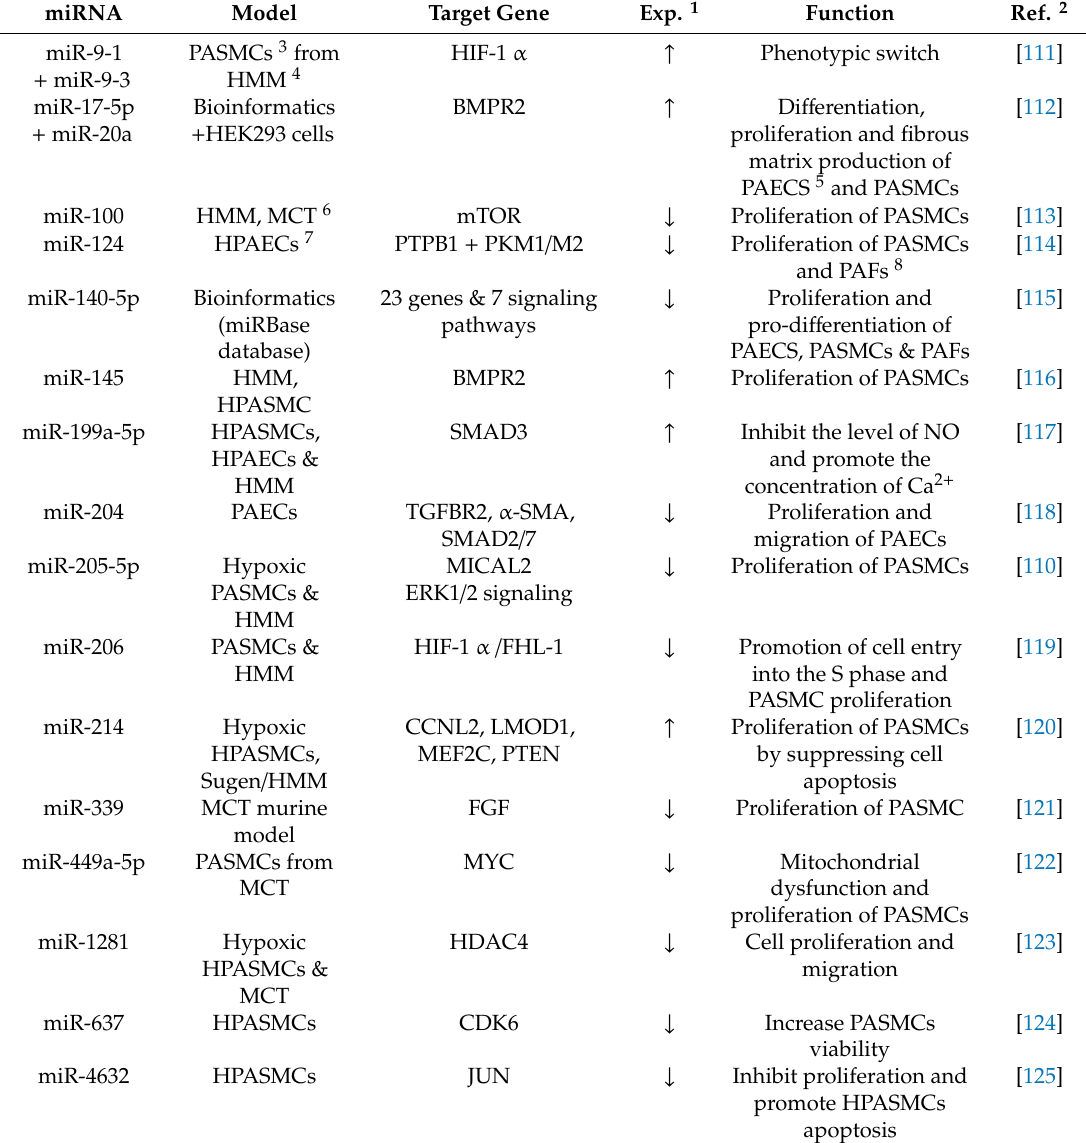
Table 2. Reported dysregulated miRNA biomarkers in pulmonary hypertension, origin of the obtained data, reported targets and miR